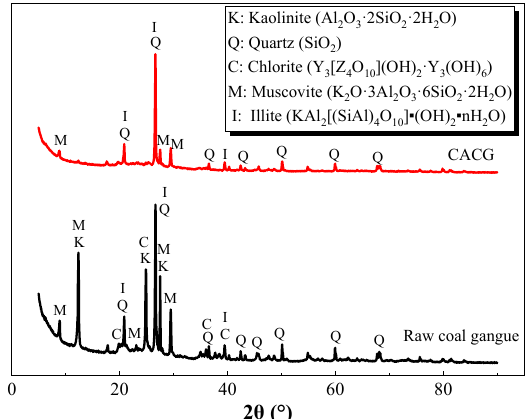
Figure 1. XRD spectra of raw coal gangue and CACG.